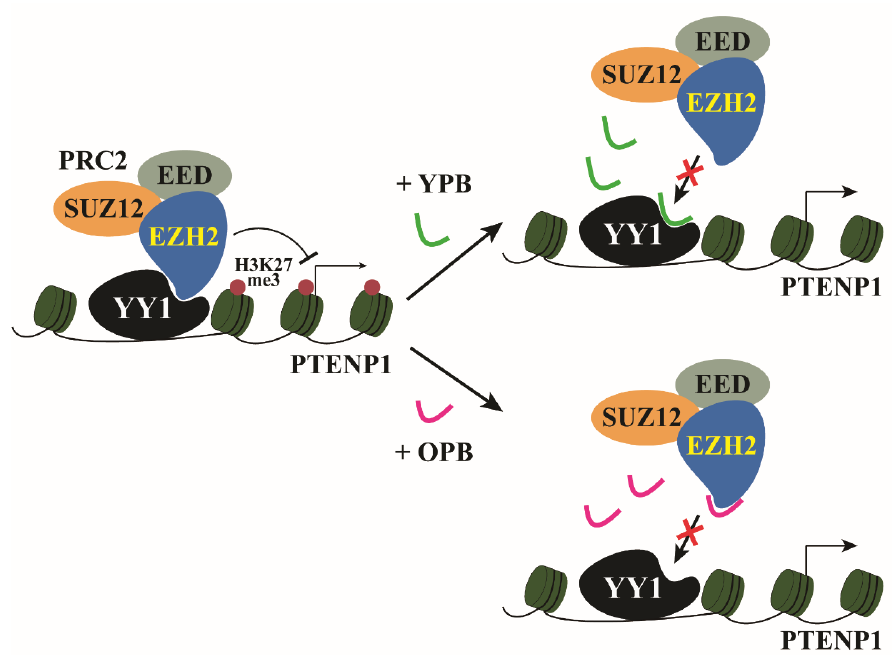
Figure 8. Schematic models of the inhibition of PTENP1 expression by the YPB and OPB peptides. In breast cancer cells, YY1 recruits EZH2 and its associated PRC2 to mediate H3K27me3 in the PTENP1 promoter and repress its expression. YPB and OPB can bind either YY1 or EZH2, respectively, to disrupt the recruitment of EZH2 by YY1, leading to reduced H3K27me3 at the PTENP1 and its upregulation.